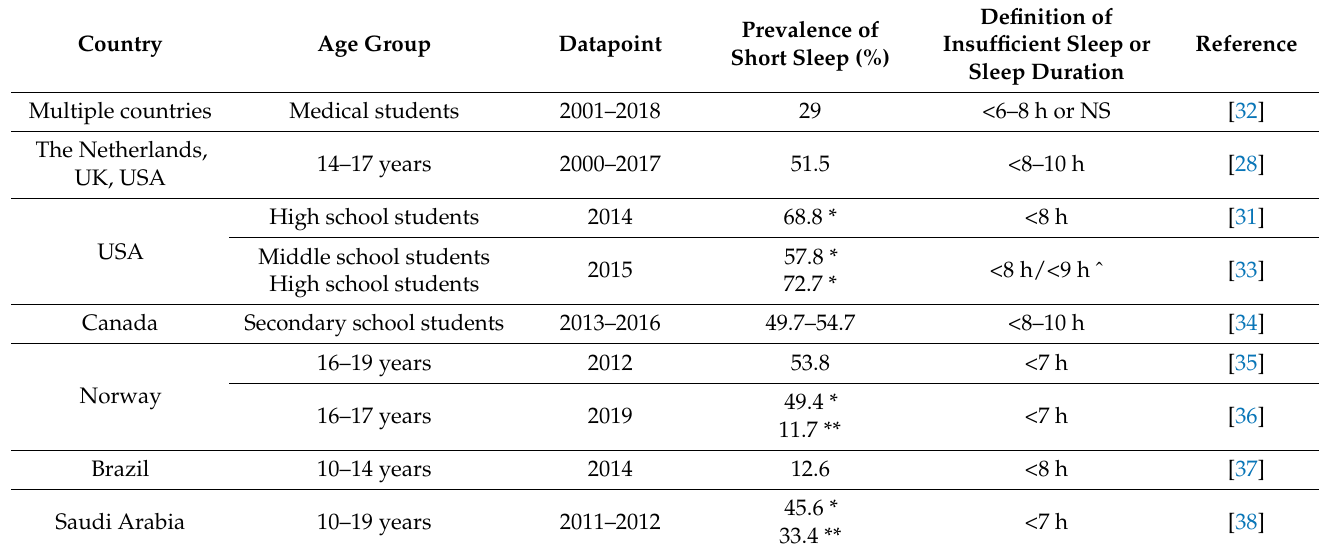
Table 2. Pre-pandemic prevalence of short sleep duration in the younger segment of the population.